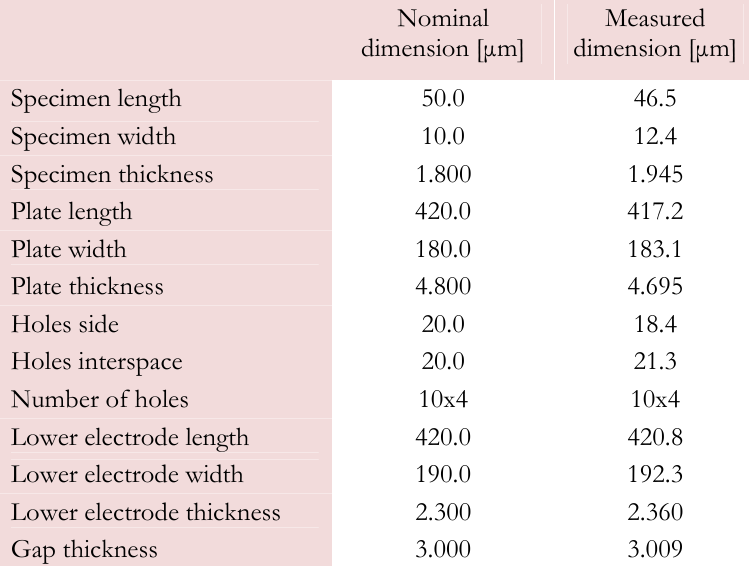
Table 1: Nominal dimensions and dimensions measured by optical profilometer on actual samples for shear and flexural fatigue